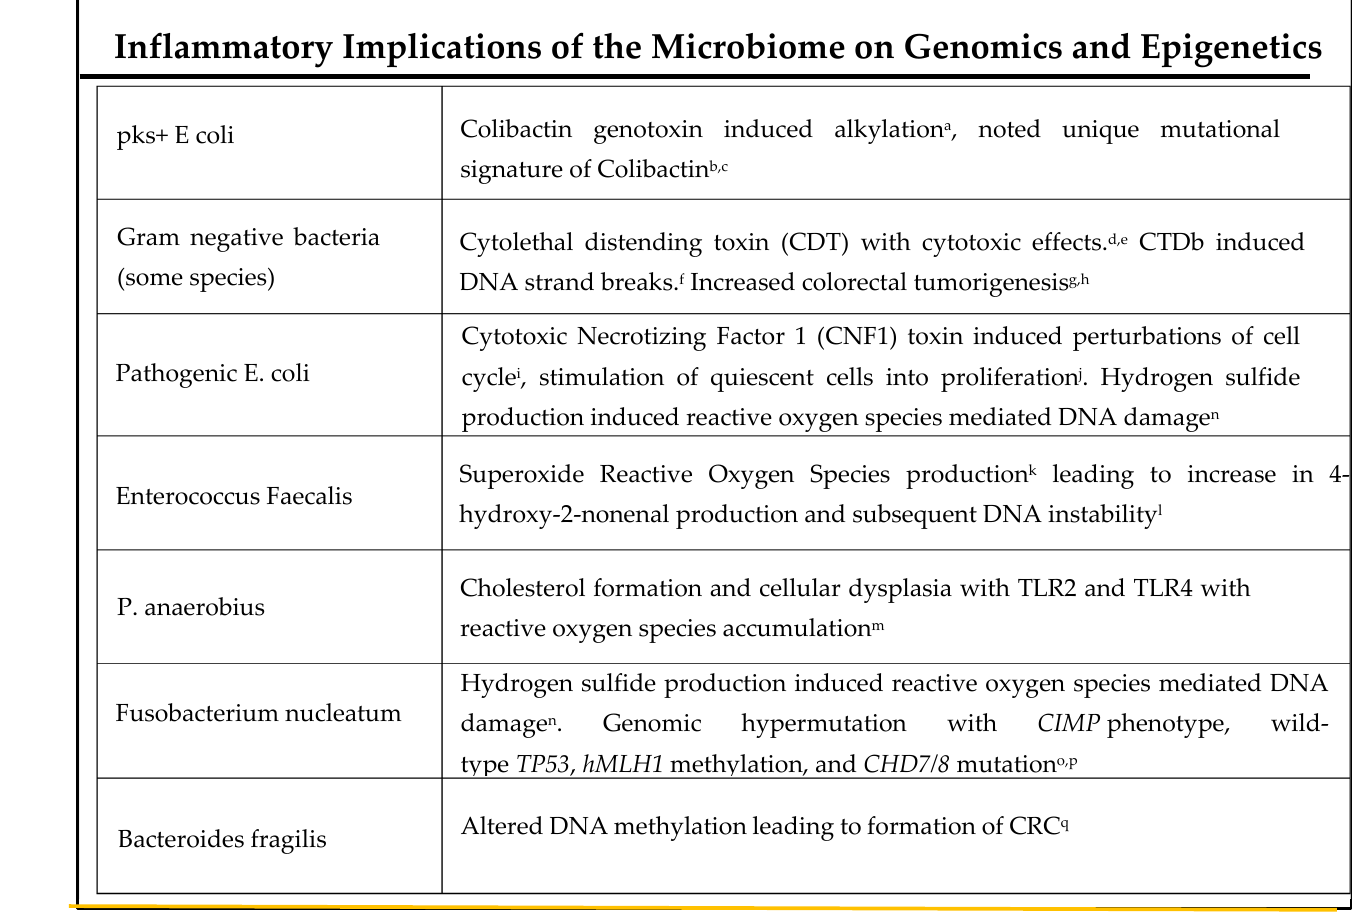
Figure 2. A depiction of how bacteria can lead to genetic and epigenetic changes of intestinal epithelium via DNA methylation, genotoxins and reactive oxygen species. a -Bonnet et al. 2014, b -Arthur et al. 2020, c -Dziuba´nska-Kuibab et al. 2020, d -Gargi et al. 2012, e -Guerra et al. 2009, f -Fahrer et al. 2014, g -Buc et al. 2013, h -He et al. 2019, i -El-Aouar Filho et al. 2017, j -Giamoi-Miraglia et al. 2007, k -Srinivas et al. 2019, l -Gunasekera et al. 2020, m - Tsoi et al. 2017, n -Barrett et al.